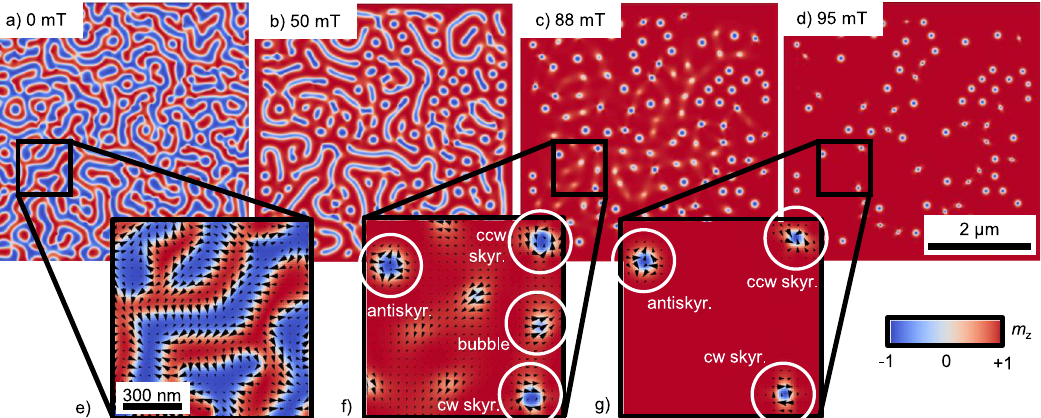
Fig. 4 Micromagnetic simulations of the domain morphology. The domain morphology is simulated using magnetic parameters close to the sample [Fe/ Ir/Gd] 2 /[Fe/Gd] 76 /[Fe/Ir/Gd] 2 . a – d show the domain morphology at a larger scale with the color illustrating the z -component of the magnetization. e – g display an enlarged portion with black vectors showing the x - and y -components of the magnetization. a , e display the relaxed magnetization state at zero fi eld showing stripes with different chiralities bristled with Bloch lines. In ( b ), an external magnetic fi eld of μ are coexisting. An external magnetic fi eld of μ 0 H z = 88 mT reveals the coexistence of type-2 bubbles, Bloch skyrmions with both cw and ccw chiralities, and antiskyrmions ( c , f ). In ( d , g ), only topologically protected spin structures (skyrmions/antiskyrmions) remain at 95 mT.